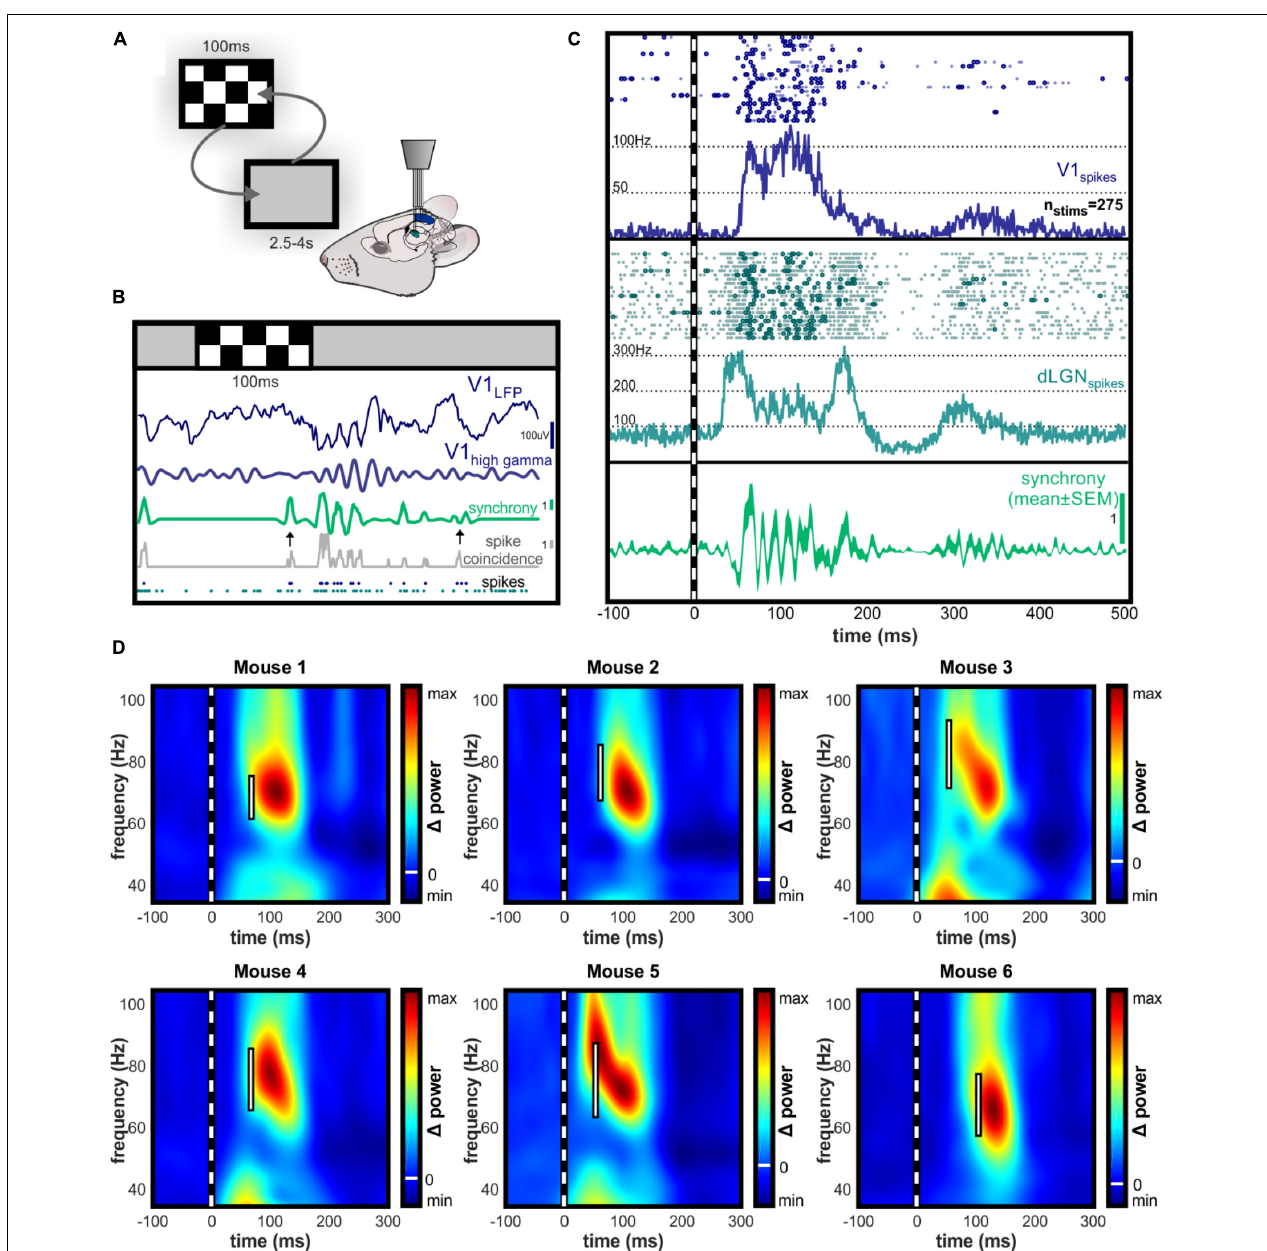
FIGURE 3 | Time-resolved spike synchrony is rhythmic in the high gamma range. (A) Illustration of experimental setup during randomized presentation of high contrast checkerboard image. (B) Single trial example of dLGN-V1 spike synchrony and V1 LFP following checkerboard stimulus. Synchronous bursts of spikes are observed following presentation of the checkerboard image, which align with the gamma oscillation observed in V1. Gray trace represents the number of dLGN-V1 spike coincidences within a sliding 4.5 ms window. Green trace represents time-resolved spike synchrony, which is taken from the coincidence rate and adjusted for spike rate using spike-time jittering (see Section “Materials and Methods” for details). Scale bar shows height of 1 coincidence above mean probability for the concurrent spike rate within the jittering time window ( ± 10 ms). Note the two black arrows indicating moments of equal spike coincidence, but high (left) versus low (right) spike synchrony values after the jitter correction is applied. This highlights the sensitivity of the method to the precise alignment of spikes rather than increases in spike rate. (C) Example raster plot for V1 and dLGN spikes occurring in 20 consecutive trials, and peri-stimulus histogram over all trials. Dark circles in raster plot highlight spikes occurring synchronously above the chance probability for the concurrent spike rate. After initial dLGN burst and V1 response, dLGN spikes appear to be modulated at an approximate 68 Hz rhythm. Bottom panel shows synchrony function averaged over trials to reveal rhythmicity of synchronous spikes locked to the stimulus onset. (D) Peak amplitude of high gamma oscillations in V1 LFP occurs following the peak of rhythmic spike synchronization in the same frequency range. Individual examples of contrast-evoked gamma oscillations with latency and bandwidth of peak spike synchrony superimposed. White bar spans the bandwidth of 95% maximal amplitude of rhythmic spike synchrony. All color axes are normalized to maximum amplitude increase and decrease with white line indicating zero amplitude